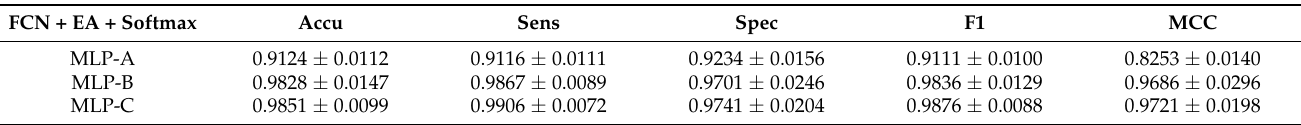
Table 9. The classification performance of the MLP models after adding the external-attention module and